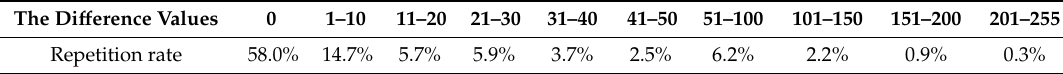
Table 1. The ratio of the difference values NEI pixels and their surrounded pixels in window of size 3 × 3. The Di ff erence